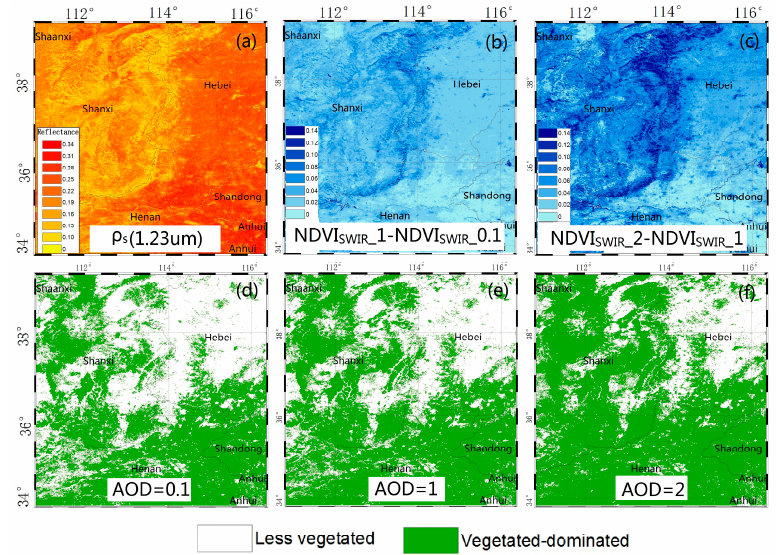
Figure 9. ( a ) MODIS surface reflectance at 1.23 µm over the NCP. The NDVI SWIR values were simulated by using the surface reflectance under aerosol conditions of AOD = 0.1, 1 and 2. ( b ) Difference in the NDVI SWIR simulation values between AOD = 1 and 0.1. ( c ) Difference in the NDVI SWIR simulation values between AOD = 2 and 0.1. The surface type identification results under different aerosol loads of ( d ) AOD = 0.1, ( e ) AOD = 1 and ( f ) AOD = 2 were also identified.